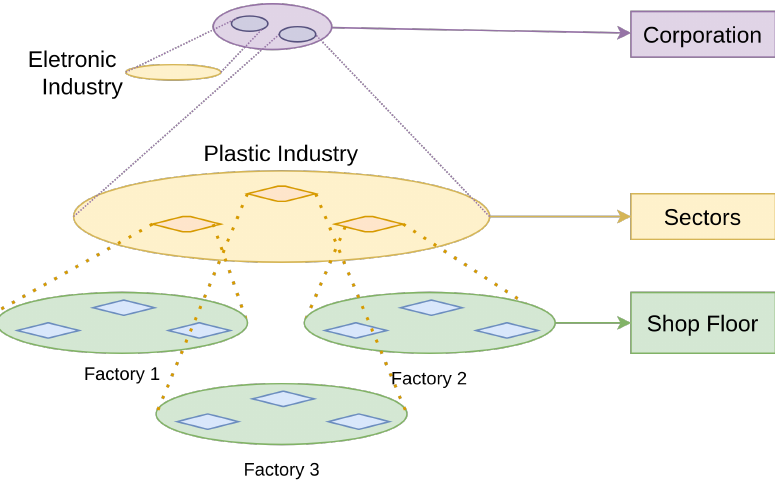
Figure 2. Holonic representation of PRESIB architecture.